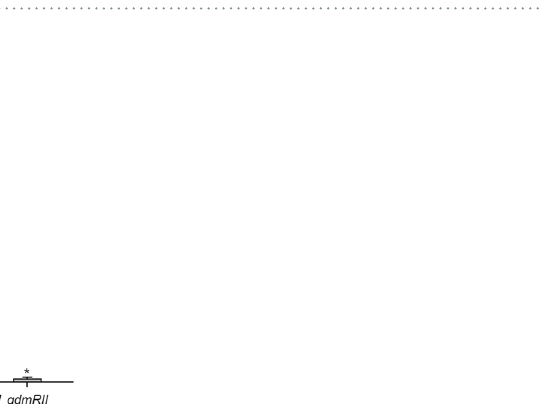
Figure 2. The geldanamycin (GDM) and the elaiophylin (ELA) gene clusters from S. autolyticus CGMCC0516 unveiling the genes regulated by GdmRIII and the steps that these genes participate in their respective biosynthetic pathways.